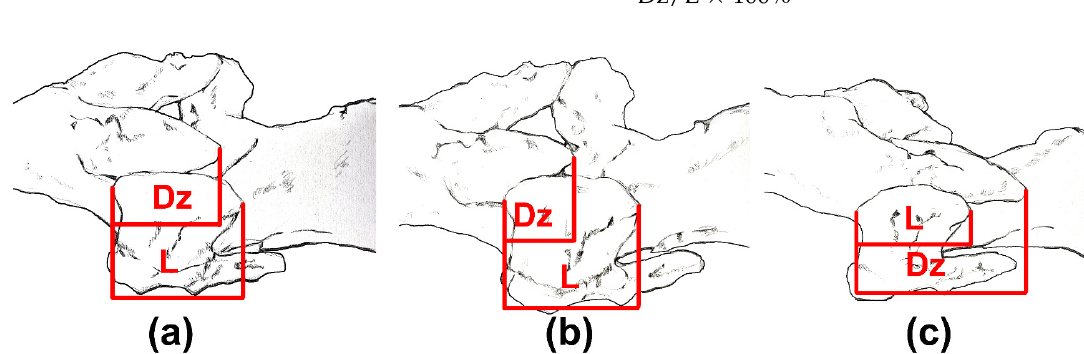
Figure 2. Schematic diagram showing the measurement of Zygapophyseal overlap for the adjacent facet. Dz: The amount of postzygapophyseal overlap with reference to the prezygapophysis. (L: The length of the prezygapophysis. ( a ) Two vertebrae in the normal state. ( b ) The state of the two vertebrae during ventroflexion. ( c ) The state of the two vertebrae during dorsiflexion.